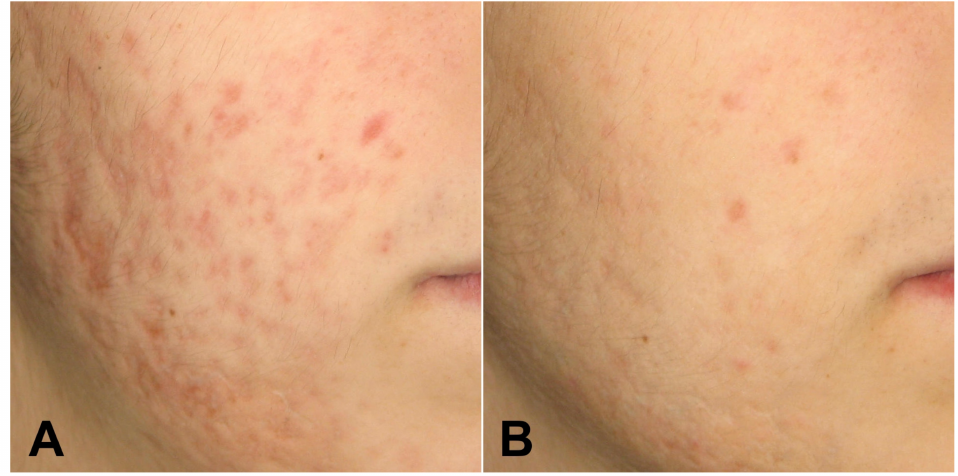
Figure 2. Patient 14 before ( A ) and 3 months after ( B ) treatments under polarized light.